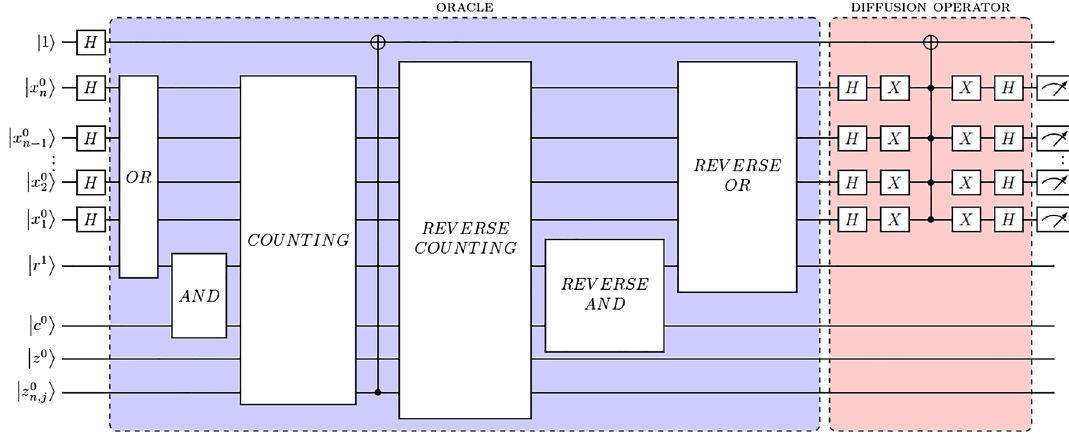
Figure 9. Circuit schematic for the entire quantum